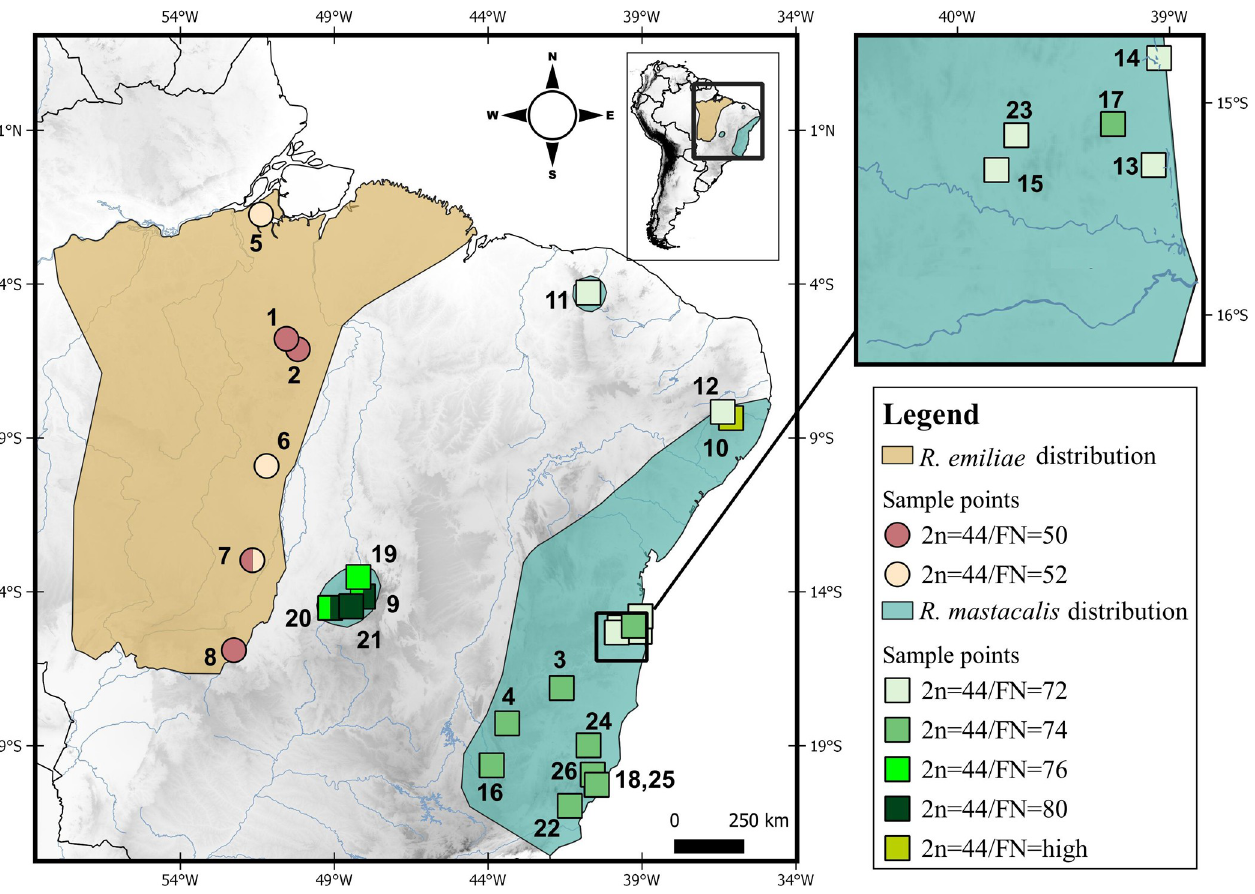
Fig 1. Map showing the distribution areas and collection points of R . emiliae and R . mastacalis with cytogenetic data available in the literature, and the specimens karyotyped in the present study (localities 1–4). The distribution data were extracted from the literature [6, 7]. Other information from the literature is shown in Table 1. The diploid number (2n) and autosomal fundamental number (FN) are based on the information in Table 1. The numbers refer to localities in Tables 1 and 2. The database was obtained from DIVA-GIS [13].